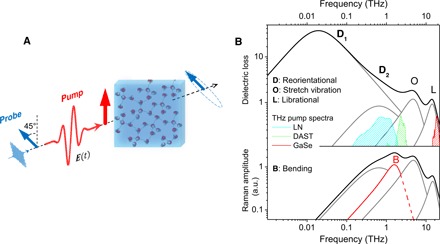
Dynamic TKE.(A) An intense THz pump pulse induces optical birefringence in water. The effect is monitored by an optical probe pulse that becomes elliptically polarized upon traversing through the medium. (B) Equilibrium dielectric loss (Im ε) and incoherent Raman spectra of water (26). Two Debye processes and two vibrations (network stretch vibrations and single-molecule hindered rotation, libration) are typically sufficient to fit the dielectric spectrum of water (25). The Raman spectrum of water lacks the first Debye process (26), but the H-bond bending vibration (red line) gains a significant amplitude. The spectra of the excitation THz fields at ~1, ~3, and 19 THz are indicated by the cyan, green, and red dashed areas, respectively. a.u., arbitrary units.